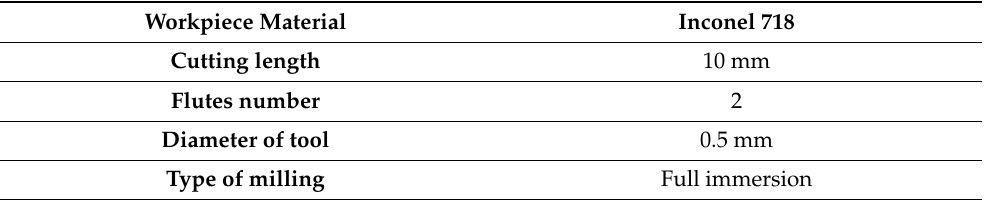
Table 1. Experimental